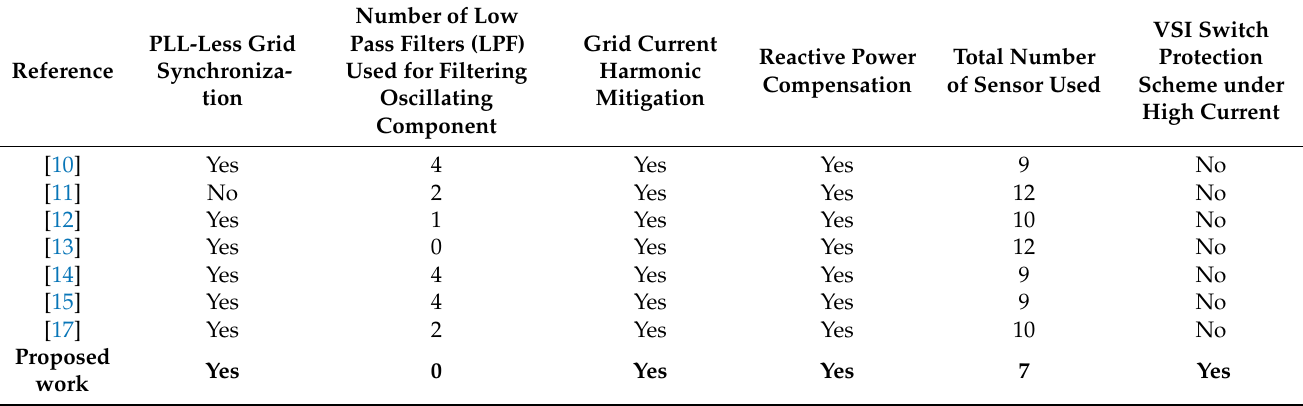
Table 1. Comparison of existing work with proposed